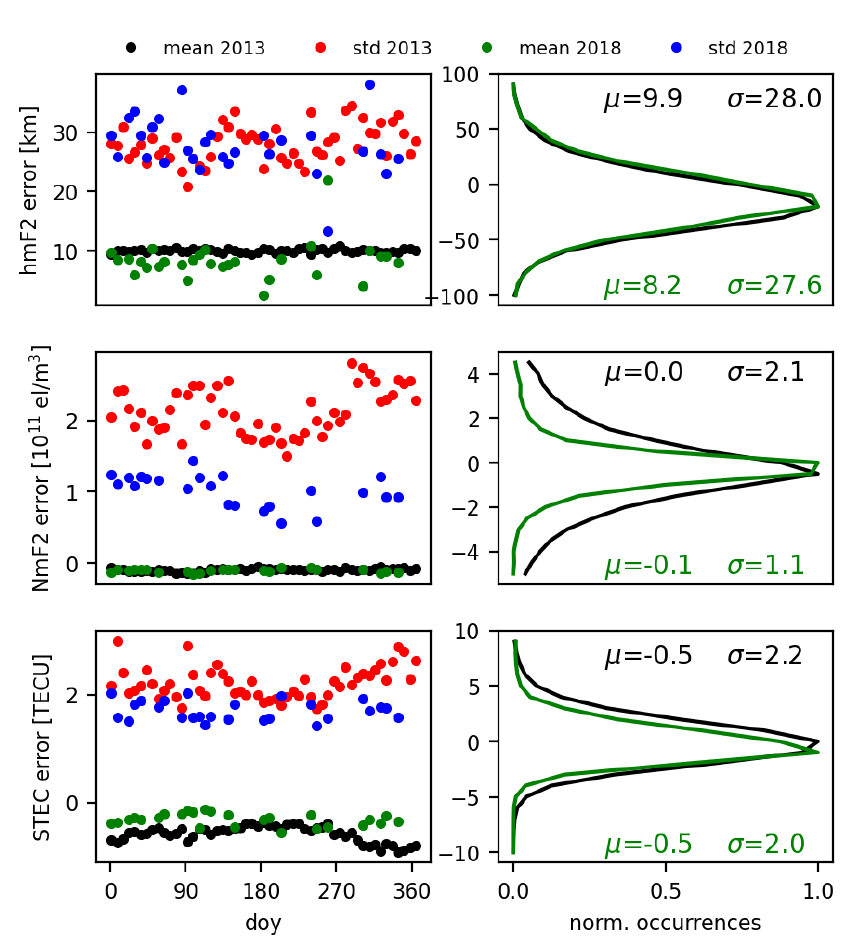
Figure 3. Overview of the residuals of the developed method in comparison to RO peak electron density and satellite-based TEC. The left panel shows the temporal series of the standard deviations and daily averages of the errors computed for 2013 and 2018. The right panel shows the histogram of normalized occurrences of the errors, with the corresponding mean ( µ ) and standard deviation ( σ ) of the